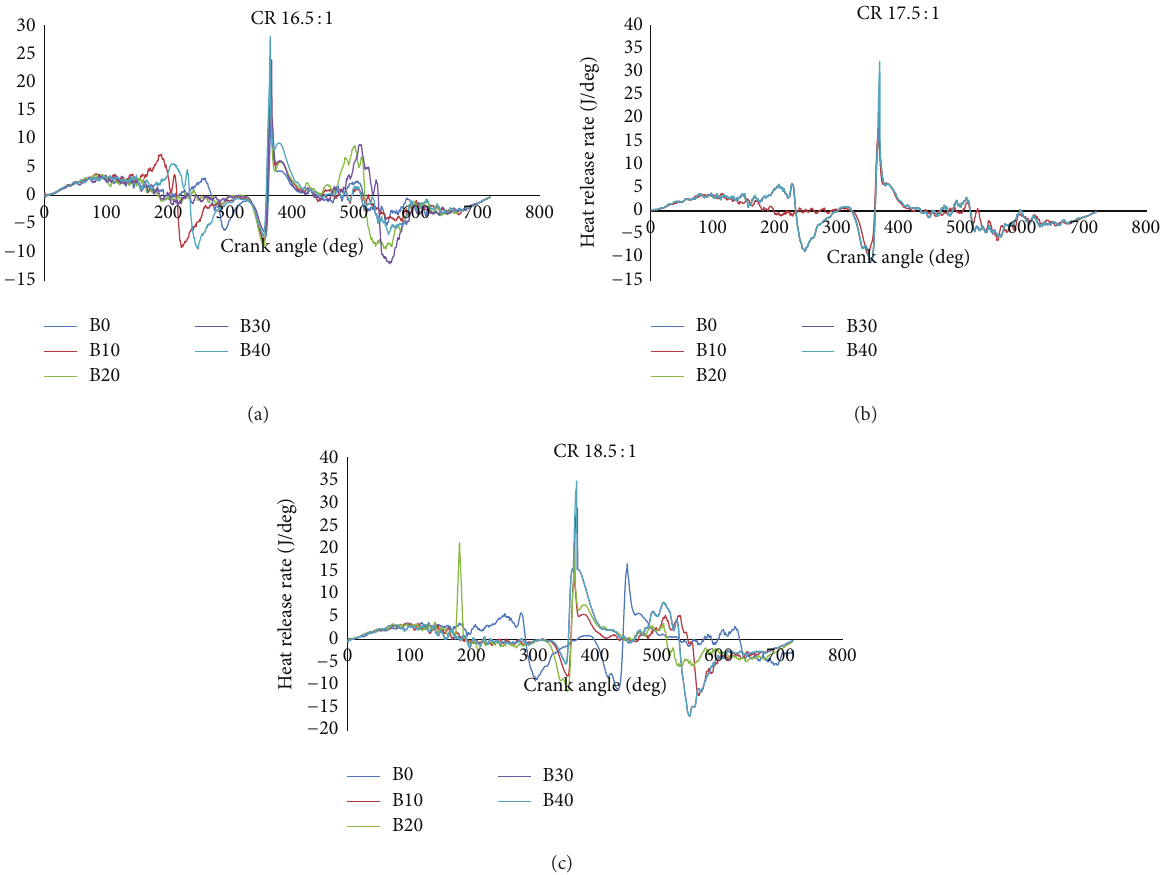
Figure 5: Comparison of the heat release rate for diesel and different ethyl ester blends at 75% of rated load for different compression